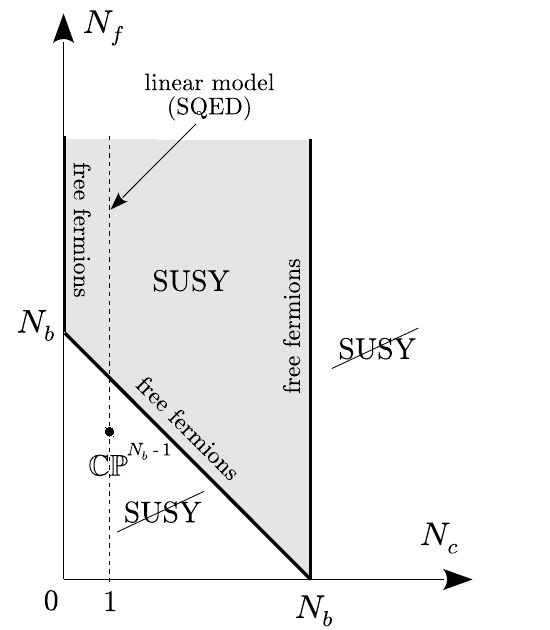
Figure 2 . The phase diagram of U( N c ) (0 ; 2) SQCD as a function of N c and N f (with N b kept